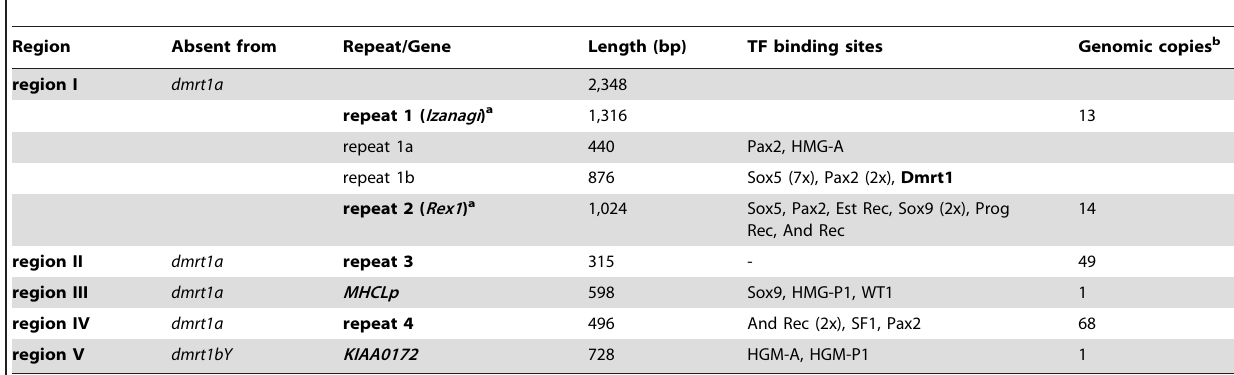
Table 1. Characterization of regions contributing to length differences between dmrt1 upstream